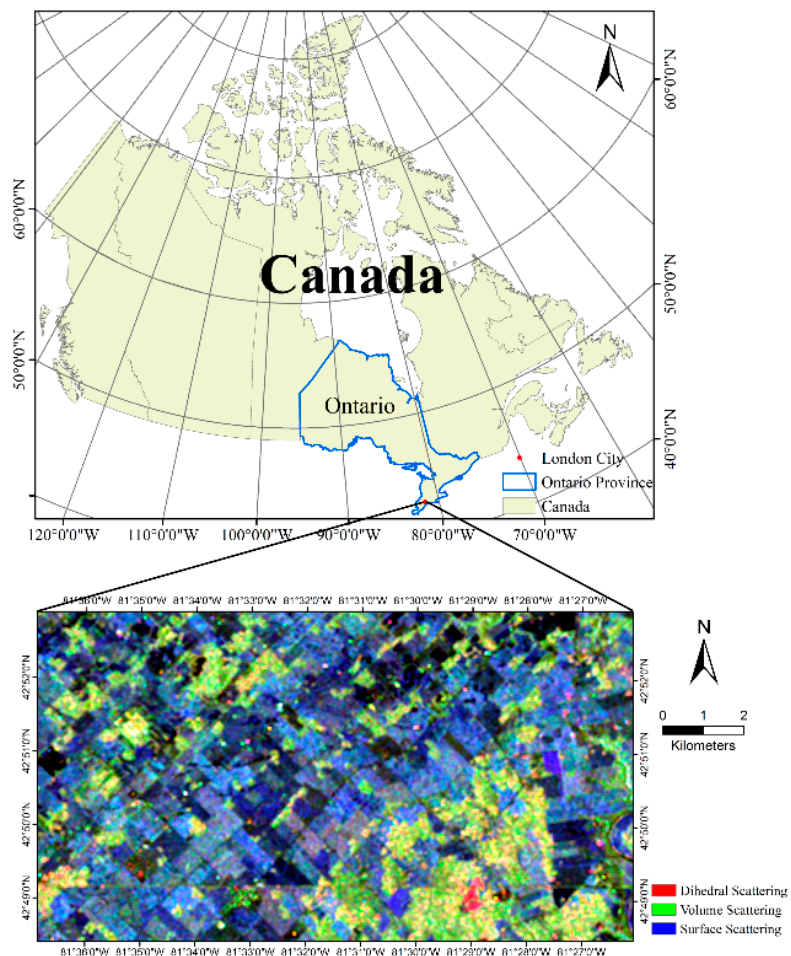
Figure 1. Location and Pauli RGB image acquired on 12 April 2015 over the overlapping area of all RADARSAT-2 images. (RADARSAT-2 Data and Products © MacDonald, Dettwiler and Associates Ltd. (2015)—All Rights Reserved. RADARSAT is an official trademark of the Canadian Space Agency). As shown in Table 1, seven fully polarimetric C-band RADARASAT-2 images in FQ10W (Fine-Quad Wide) covering the entire growing season from April to September in 2015 were employed. The uniform image acquisition beam mode offers the advantage of reduced complexity caused by varying SAR incidence angles for multitemporal